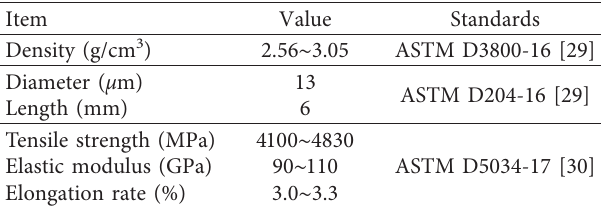
Table 2: Physical and mechanical properties of basalt fiber.